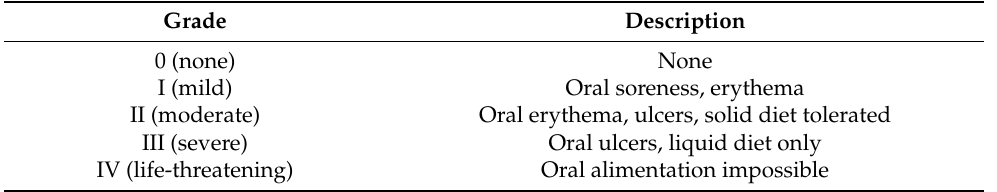
Table 1. WHO grading or oral mucositis.